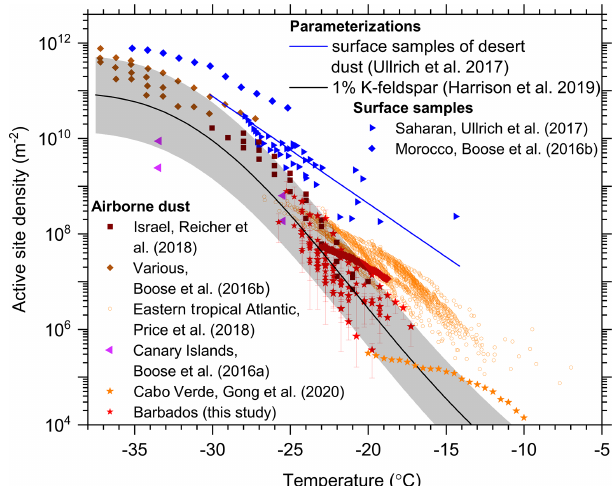
Figure 7. Ice nucleation active site surface density, n s ( T ), mea- surements for Barbados compared with literature values for African mineral dust. We have coloured all “surface samples” that were taken from the surface (either soil samples, or settled dust from a dust storm) and then analysed later in a laboratory with blue points (Ullrich et al., 2017; Boose et al., 2016b). Note that we only show data from Boose et al. (2016b) for the African sample that was not milled. The other literature datasets are for mineral dust sampled from the air in locations in or near Africa (Boose et al., 2016a; Boose et al., 2016b; Reicher et al., 2018; Price et al., 2018; Gong et al., 2020). We also show the parameterization for mineral dust sam- ples from the surface (soil samples and dust precipitated from dust storms) from multiple arid locations around the world (Ullrich et al., 2017) and an n s ( T ) parameterization for K-feldspar from Harrison et al. (2019) scaled to 1%, where the grey band is the variability in the ice-nucleating activity of K-feldspar samples (in other locations the K-feldspar content was most likely greater than